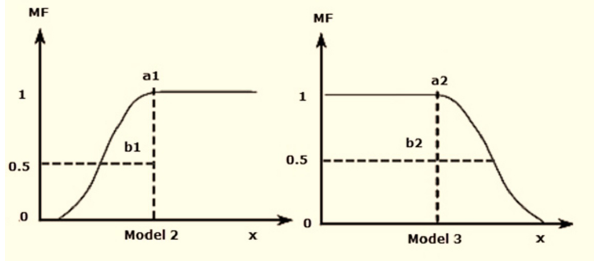
Figure 3. Membership functions.